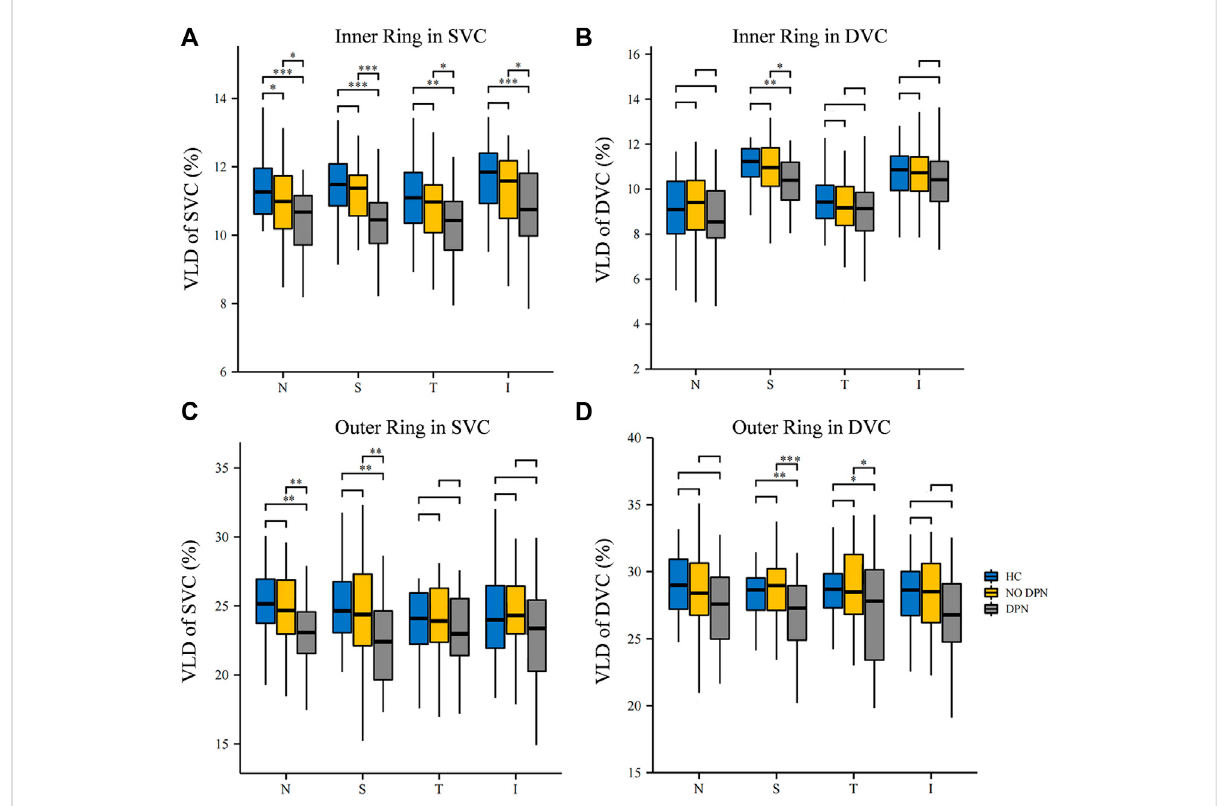
FIGURE 2 Comparison of VLD in different sectors between HC, NDPN, and DPN groups. (A) Describe the VLD of the SVC in four inner quadrant sectors (nasal inner, superior inner, temporal inner, and inferior inner). (B) VLD of DVC in four inner sectors. (C) VLD of SVC in four outer quadrant sectors (nasal outer, superior outer, temporal outer, and inferior outer). (D) VLD of DVC in four outer quadrant sectors. VLD is de fi ned as theratio of the total number of pixels on microvascular centerlines to the area of